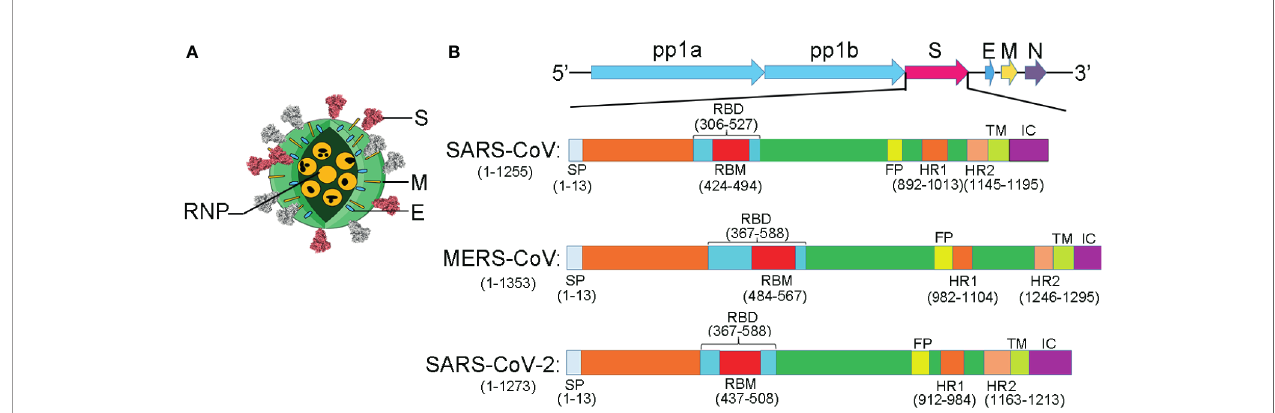
FIGURE 3 | The comparison of the structural proteins of SARS-CoV, MERS-CoV, and SARS-CoV-2. (A) Coronavirus virion structure. Coronaviruses, forming enveloped and spherical particles, are with a diameter of 100 – 160 nm. The positive-sense, single-stranded RNA (ssRNA) genome is 27 – 32 kb in size. RNP, ribonucleoproteins; S, spike; E, small membrane envelope; M, membrane are transmembrane proteins. (B) The schematic diagram for the components of the SARS- CoV, MERS-CoV, and SARS-CoV-2. A polyprotein, pp1ab, which is encoded at two-thirds of the 5 ’ -terminal of the genome, is further cleaved into 16 non-structural proteins. These proteins are involved in transcription and replication. The structural proteins, envelope glycoproteins spike (S), envelope (E), membrane (M), and nucleocapsid (N), are encoded at the 3 ’